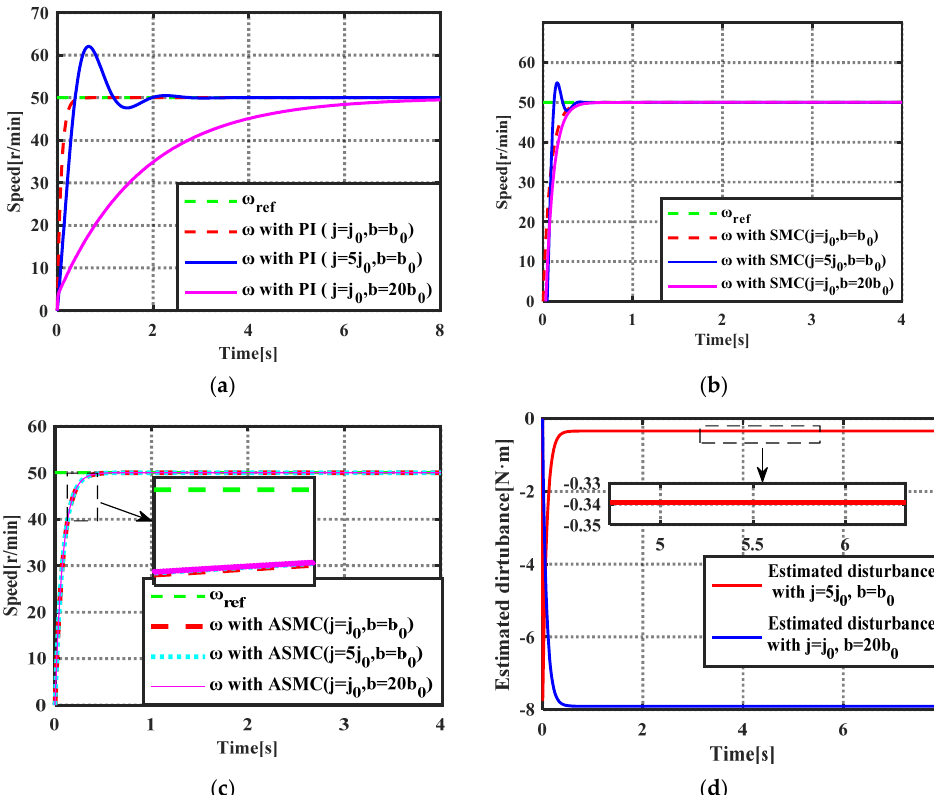
Figure 4. Simulation control diagram of the proposed control strategy.